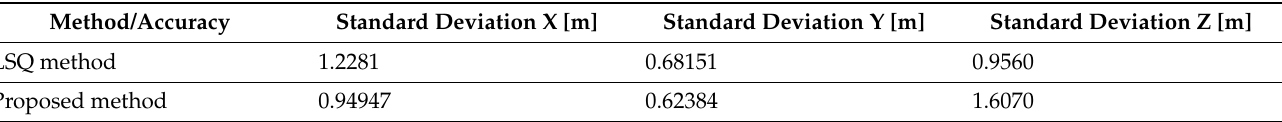
Table 3. Comparison of the results of LSQ vs. median filter method.